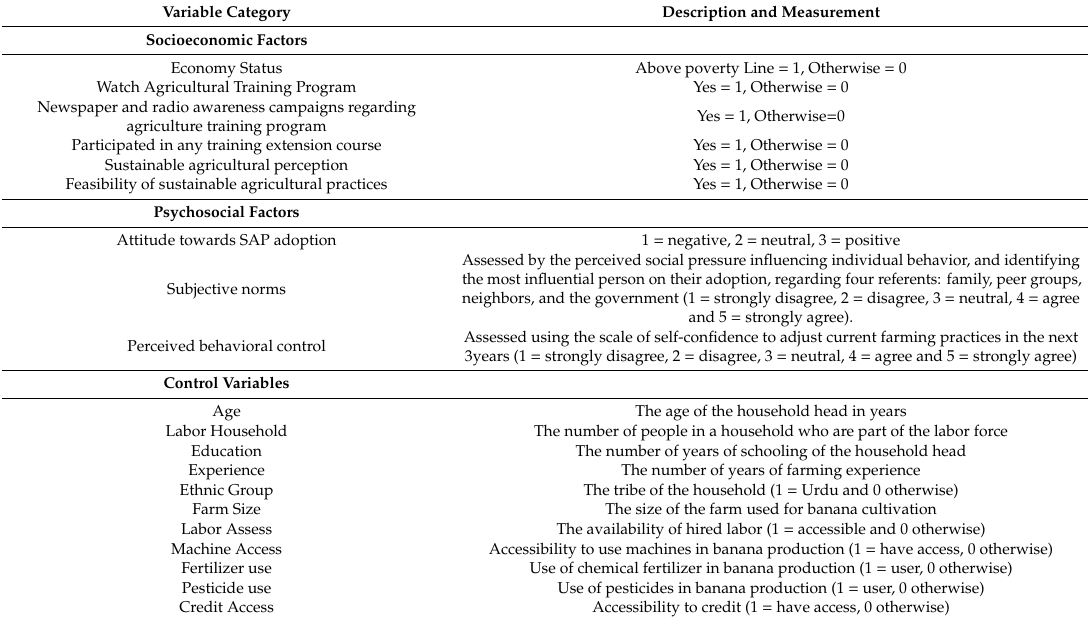
Table 3. Measurement of socioeconomic and psychosocial